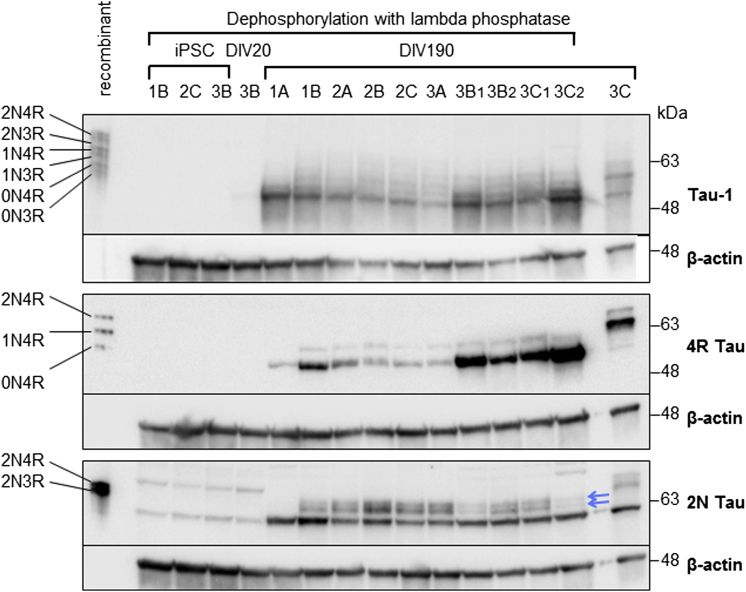
All Major Tau Protein Isoforms Are Expressed in iPSC-Derived Dopaminergic Neuronal Cultures Differentiated for 6 MonthsWestern blots showing the presence of all six major isoforms of mature tau protein in dopaminergic neuronal cultures at DIV190, as detected by antibodies against total tau (Tau-1) or specific isoforms (4R Tau, 2N Tau). All samples dephosphorylated, except the right lane as an untreated control. 2N Tau blot: central bands indicated by blue arrows represent the two 2N Tau isoforms. Additional bands are considered non-specific as they appear in the iPSC lysate in which no tau is detectable.